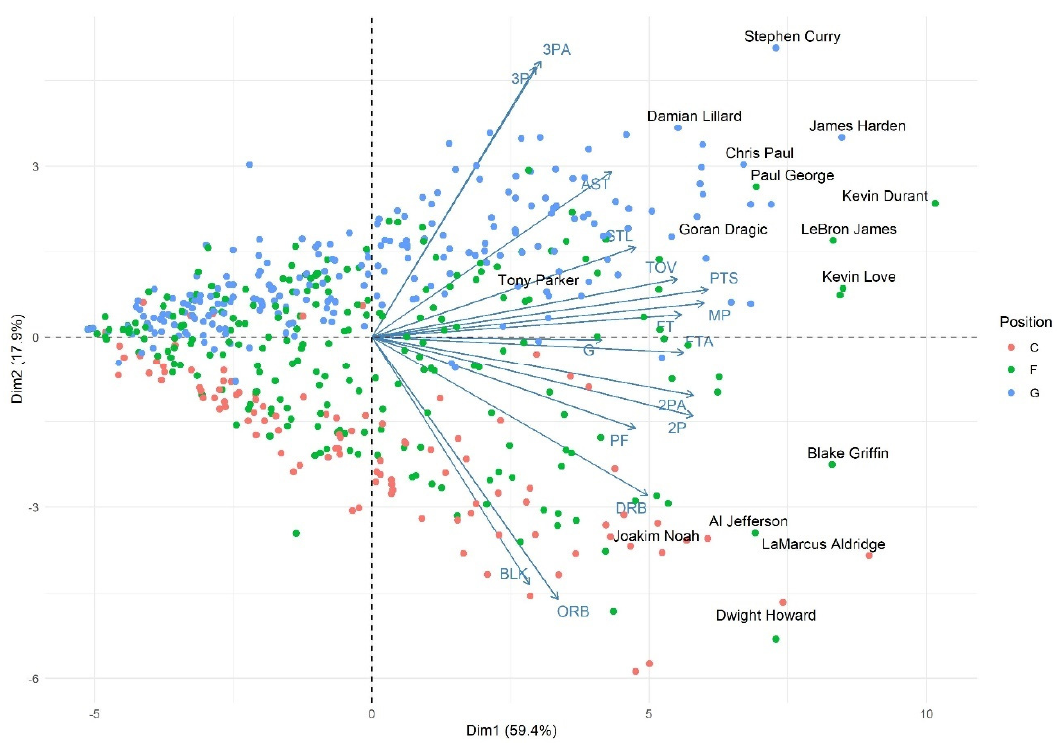
Figure A1. Principal Component Analysis of active players in the 2013–14 NBA Season.